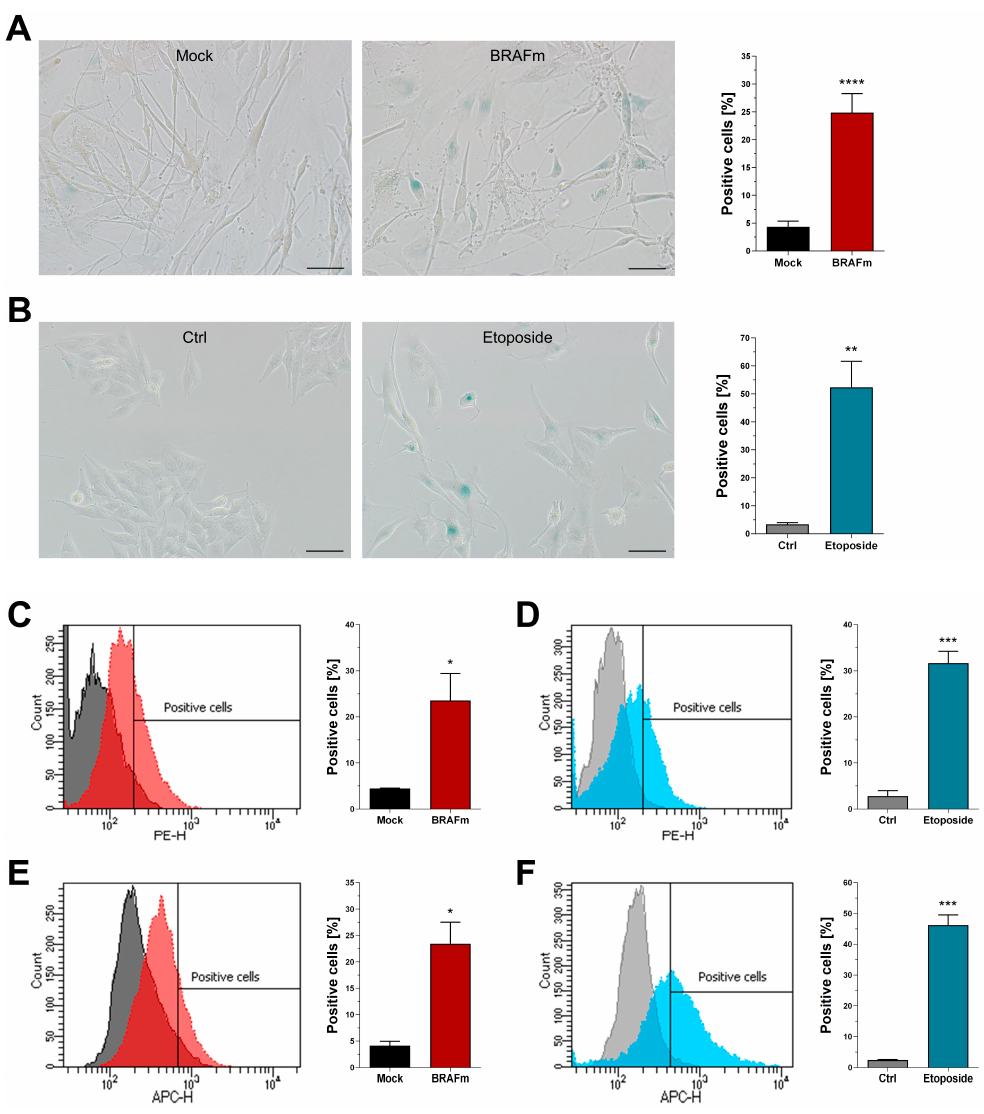
Figure 4. Quantification of SA- β -Gal activity. ( A , B ) Traditional method using X-gal and bright field microscopy (NHEM n = 7, Mel Juso n = 3). ( C , D ) Flow cytometry after staining with C 12 RG. ( E , F ) Flow cytometry after staining with DDAO galactoside. Histograms are representative examples. Scale bars equal 50 µm. Bars are shown as mean ± SEM (Student’s t -test). (*: p < 0.05, **: p < 0.01, ***: p < 0.001, ****: p < 0.0001).